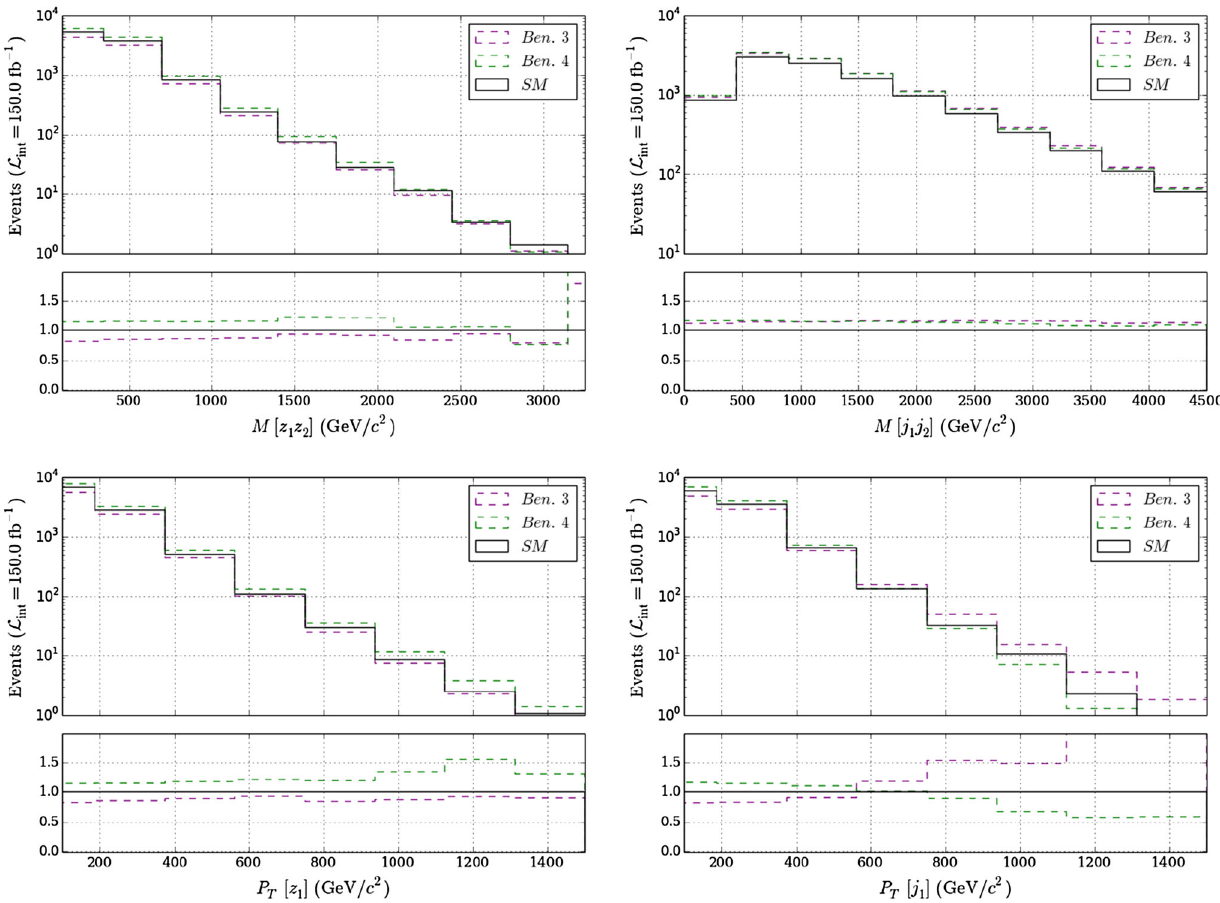
Fig. 7 SM prediction and benchmark scenarios from Table 2. It is interesting to see that although one benchmark gives a total enhancement to the cross section and the other gives a decrease, in the tail of some distributions both seem to contribute positively